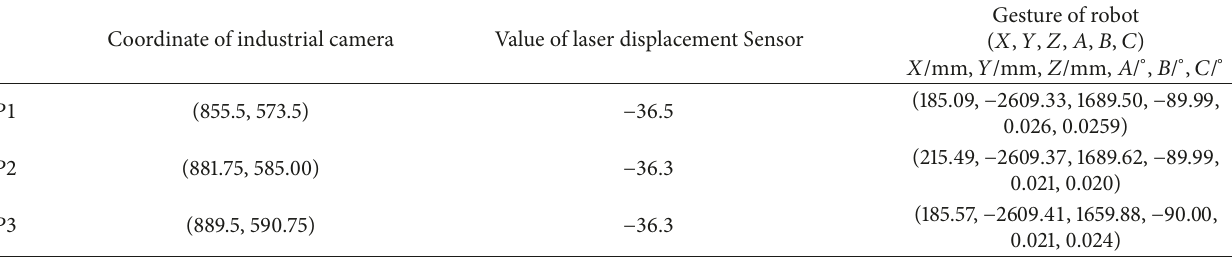
Table 7: Values before changing coordinate system.